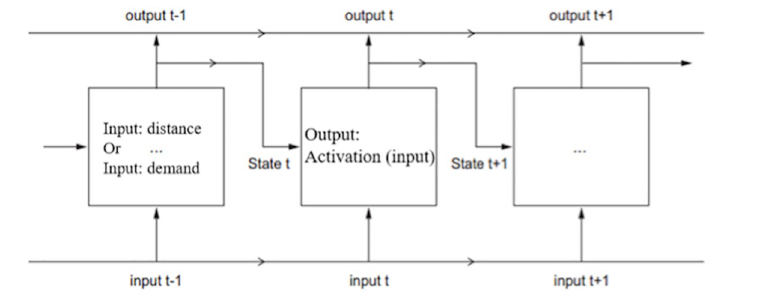
Fig 6. Simple recurrent neural network.